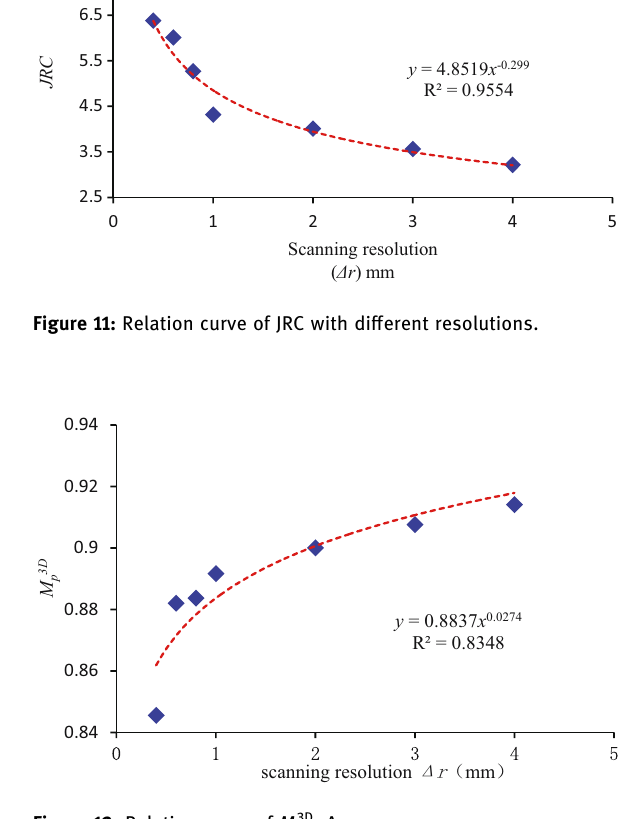
Figure 12: Relation curve of M p3D − Δ r .